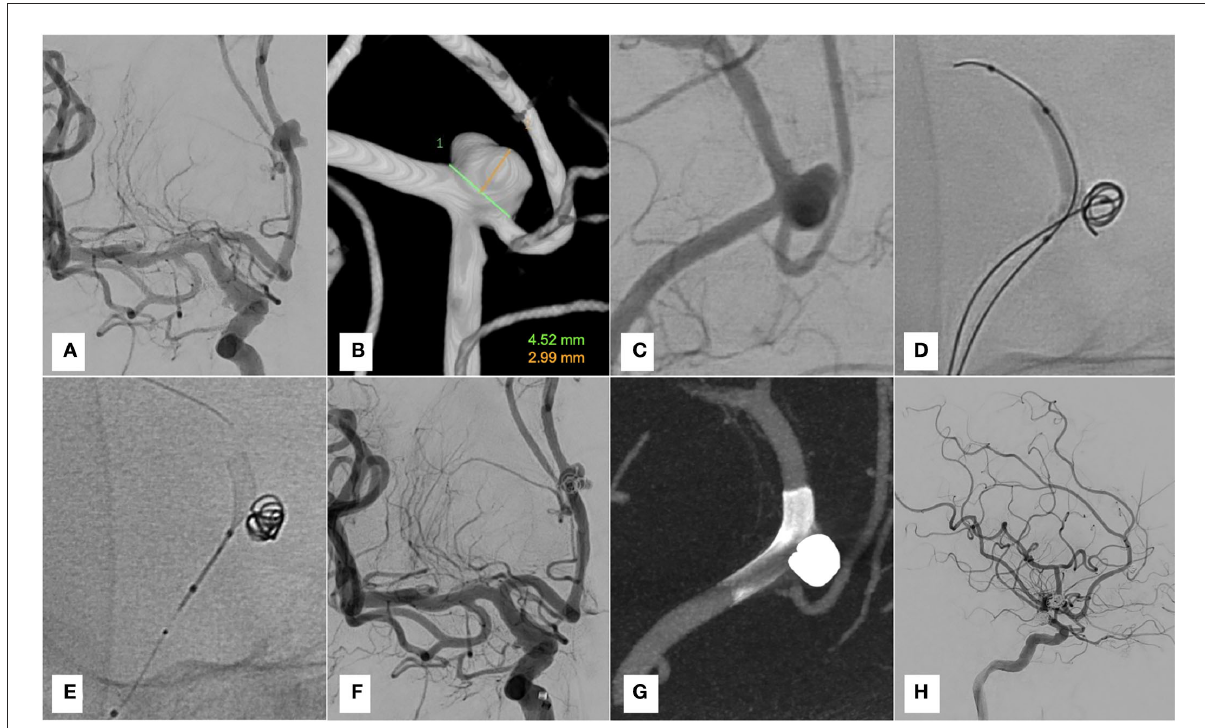
FIGURE1 Case 1. (A–C) Pre-treatment DSA and 3D reconstruction. (D) Coiling with Scepter C inflated. (E) Deployment of Derivo 2 through the dual lumen balloon. (F,G) Final run and Vaso-CT. (H) Six-month-DSA